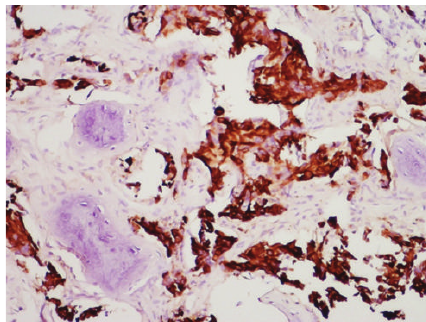
Figure4:Leftpetrousbonebiopsy,immunohistochemistrystaining positive for